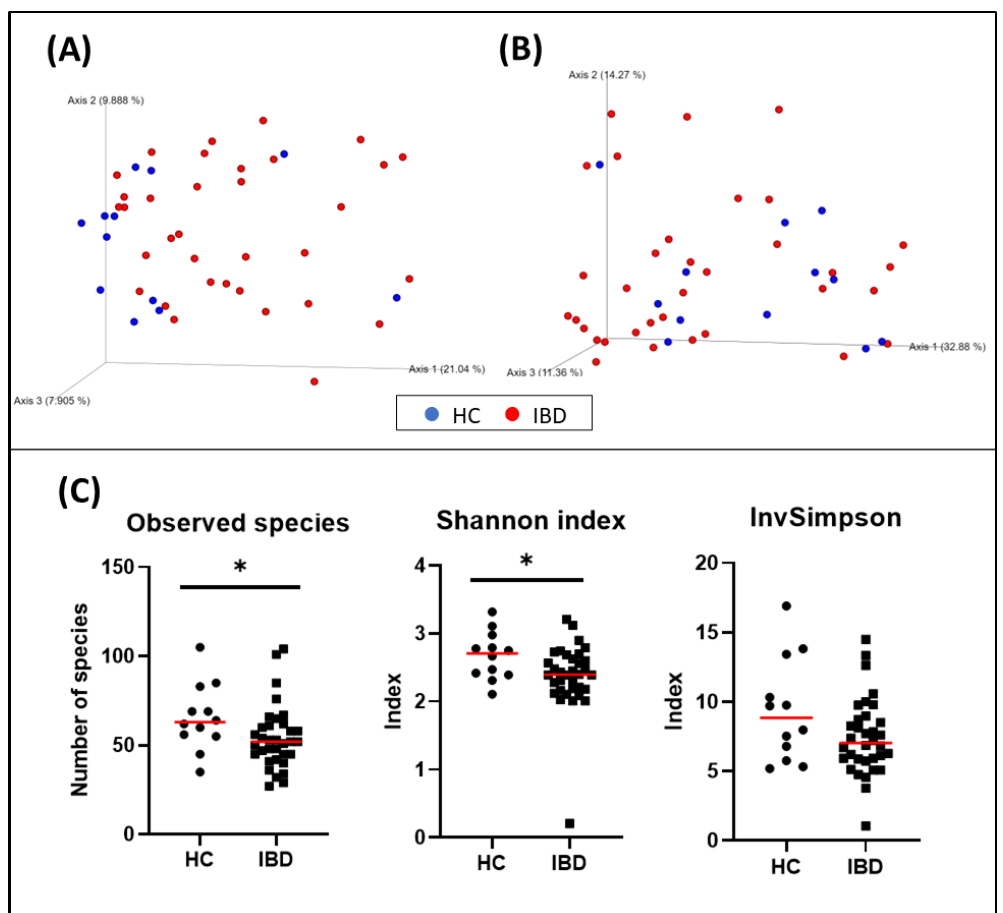
Figure 2. Bacterial diversity measures of fecal samples: The dimensional representation of principal coordinate analysis (PCoA) plots of ( A ) unweighted and ( B ) weighted UniFrac distances of 16S rRNA genes. Fecal samples from dogs with IBD were separated from those obtained from healthy dogs (PERMANOVA, p = 0.006; pseudo–F: 4.83). ( C ) Comparisons of α -diversity: observed species ( p = 0.031), Shannon index ( p = 0.039), and inverse Simpson index ( p = 0.140). Red lines represent the median for each measure. HC, healthy control dogs; IBD, inflammatory bowel disease dogs; * p < 0.05.